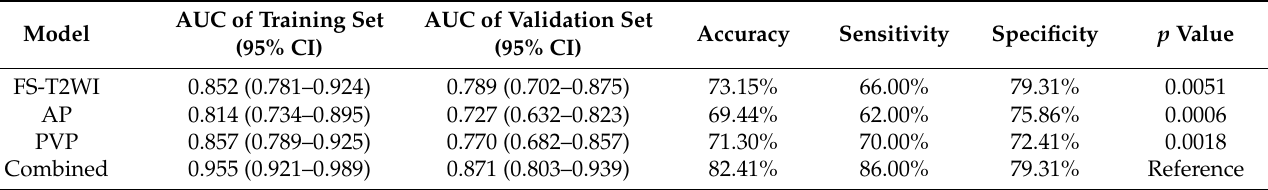
Table 3. Predictive performance of each